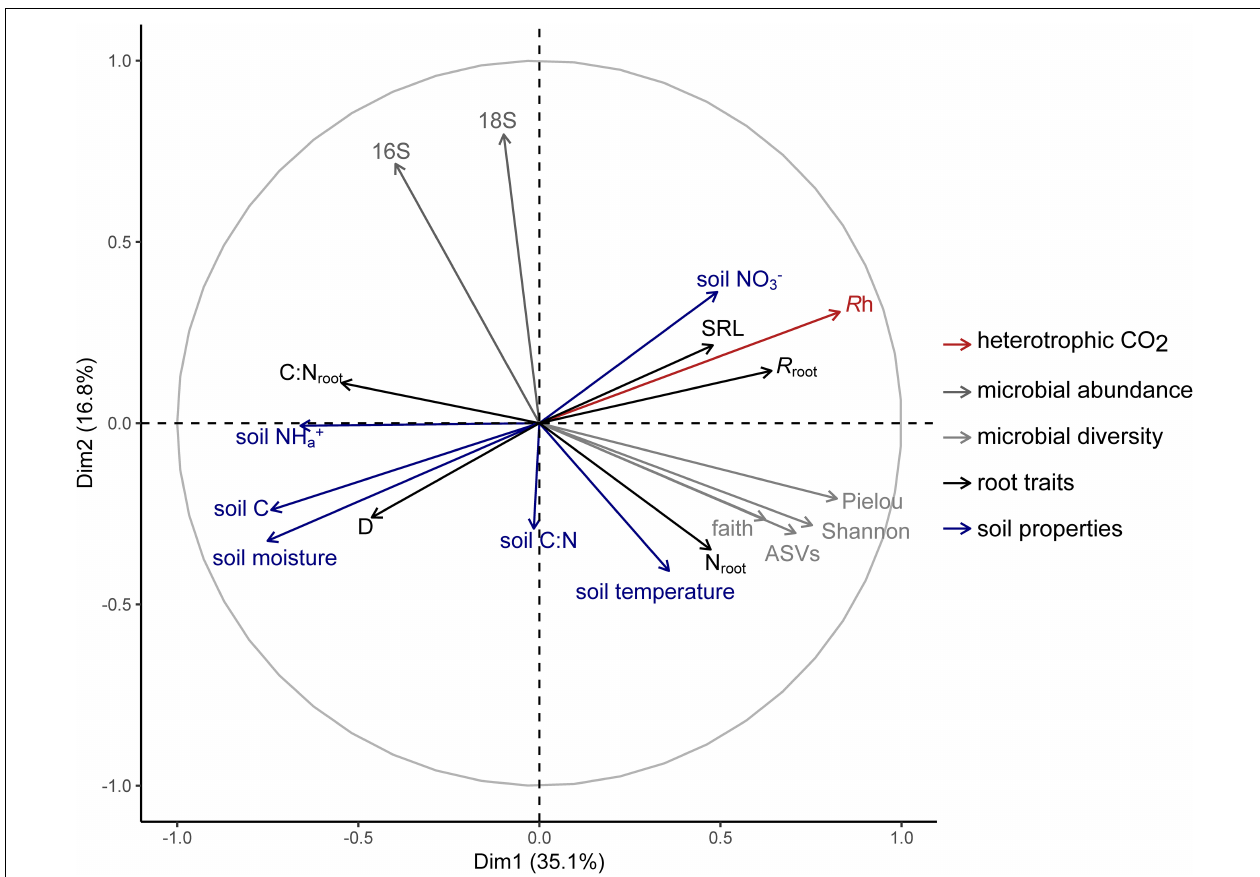
FIGURE 3 | Multiple factor analysis of heterotrophic respiration ( R h ) and grouped biotic and abiotic soil environment variables: microbial abundance [bacterial (16S) and fungal (18S) abundance]; microbial diversity [Shannon’s diversity index, Observed ASVs, Faith’s Phylogenetic Diversity, and Pielou’s evenness]; root traits [average root diameter (D), root C to N ratio (C:N,root), specific root length (SRL), root N content ( N root ), and specific root-rhizosphere respiration ( R root )]; and soil properties [soil moisture, soil temperature, total soil C, soil C:N, available NO 3 − , and available NH 4 +